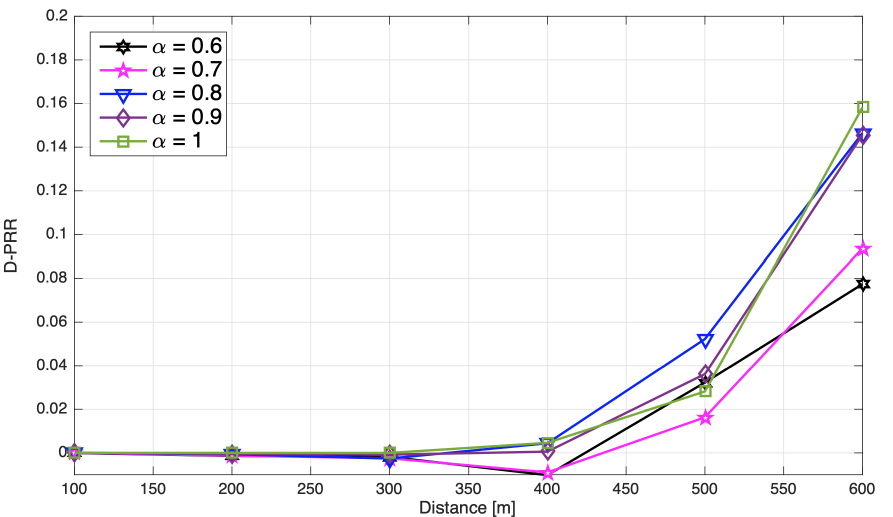
Figure 8. Difference in Packet Reception Ratio (D-PRR = PRR PFR − PRR FRR ) between both FFR and PFR bandwidth partitioning techniques versus distance for different vehicle